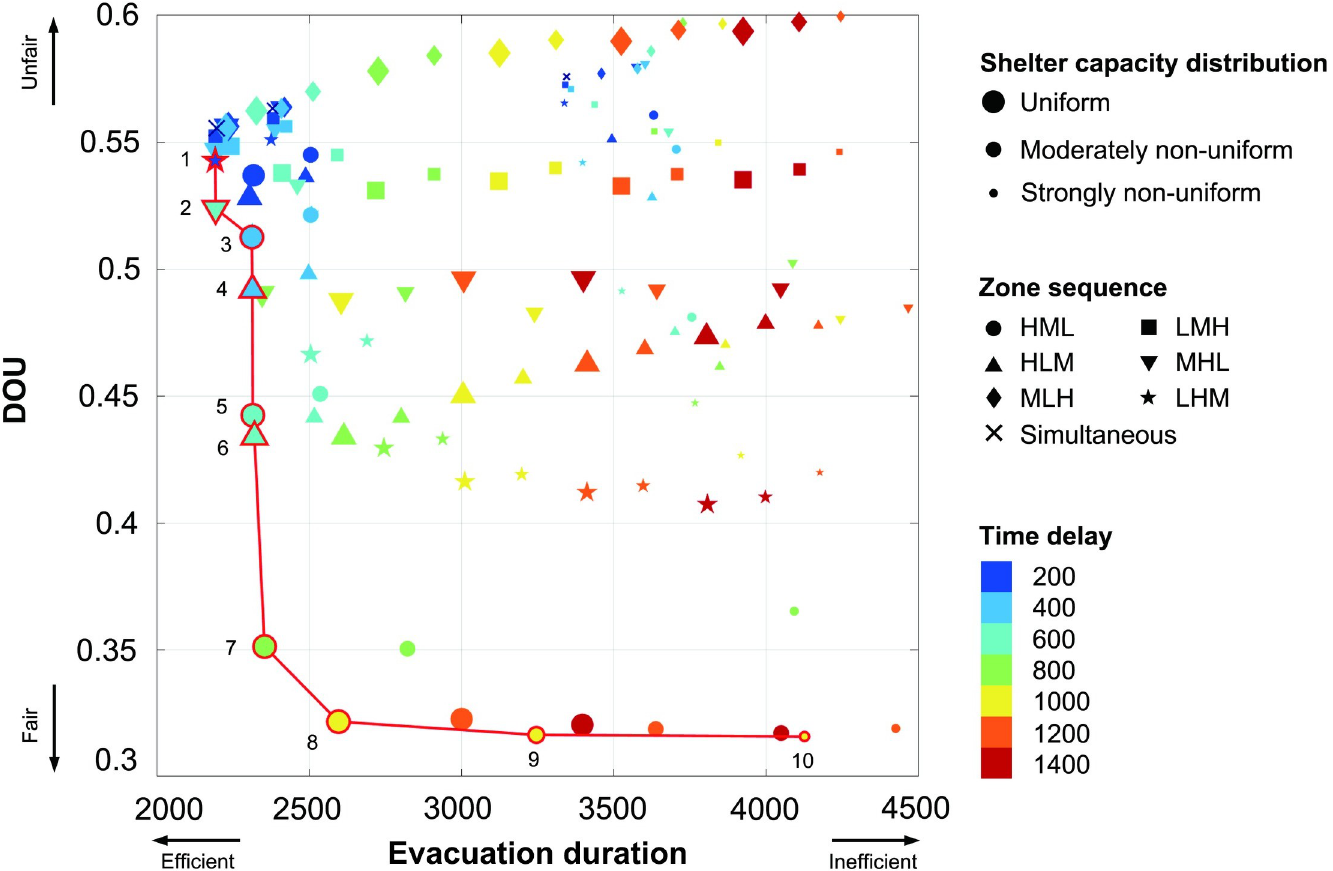
Fig 6. Pareto-optimal strategies considering efficiency (evacuation duration) and fairness (DOU). Each dot represents the mean outcomes of the evacuation duration and DOU under the different settings of hard infrastructure and institutional arrangement properties (500 simulations per dot; a total of 129 dots). The marker sizes indicate the different hard infrastructure properties (the shelter capacity distributions). The shapes indicate the different zone sequences, and the colors indicate the varying time delays. The highlighted dots with red edges are the Pareto-optimal strategies, forming a Pareto frontier (connected by red lines). The 10 Pareto-optimal strategies are as follows: 1 = LHM-200-U; 2 = MHL-600-U; 3 = HML-400-U; 4 = HLM-400-U; 5 = HML-600-U; 6 = HLM-600-U; 7 = HML-800-U; 8 = HML-1000-U; 9 = HML-1000-MN; 10 = HML-1000-SN.